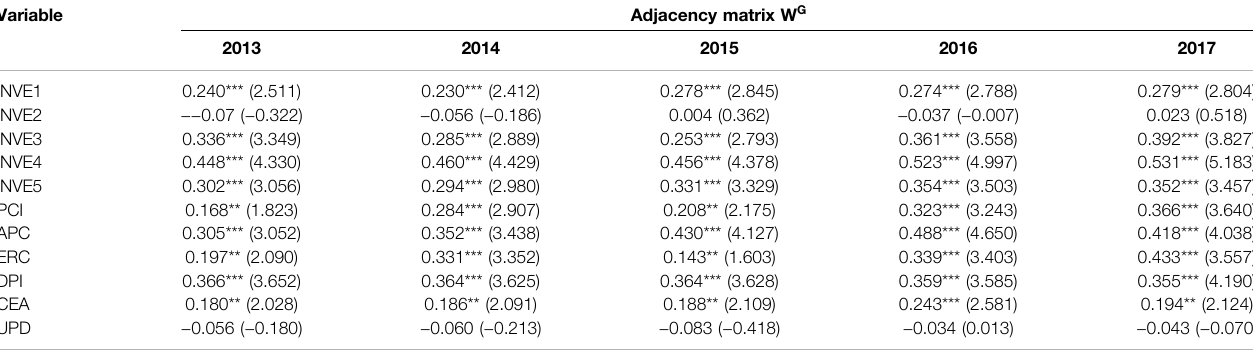
TABLE 2 | Global Moran ’ s I statistics of enterprise location selection. Variable